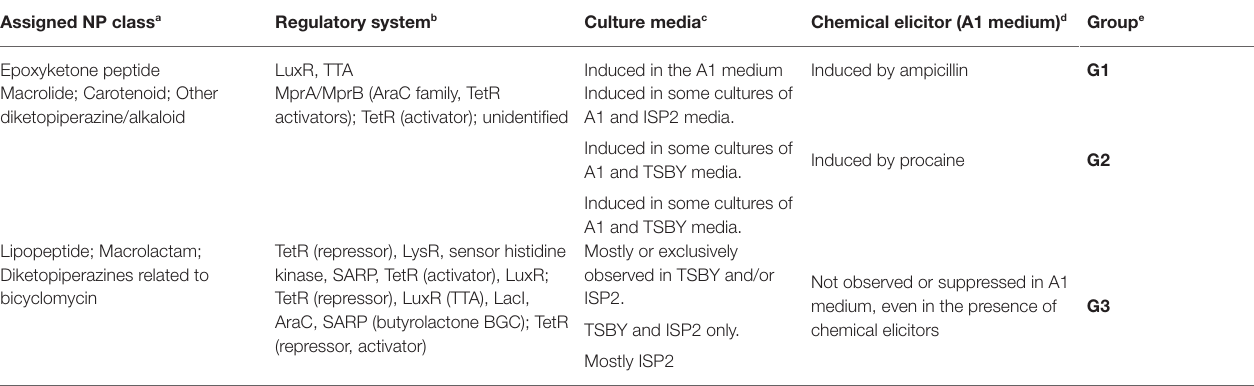
TABLE 1 | Groups of metabolites found to be regulated together in wild type BRA-346 cultures. Assigned NP class a